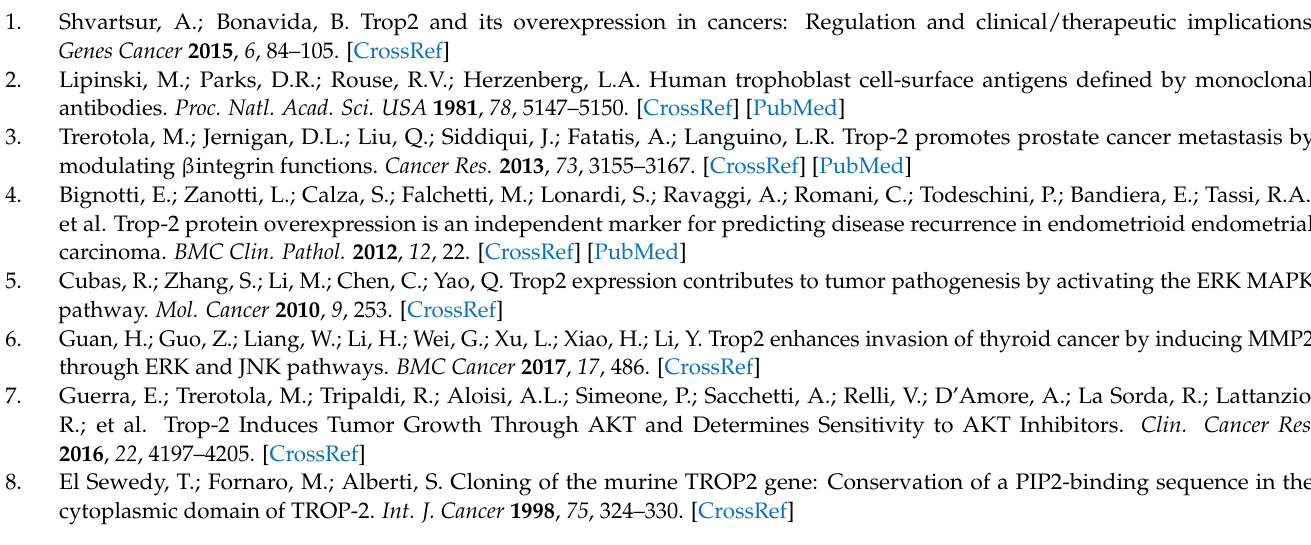
figure. A.F., E.B., D.G., G.S. and G.D. provided expert opinions and reviewed the paper. All